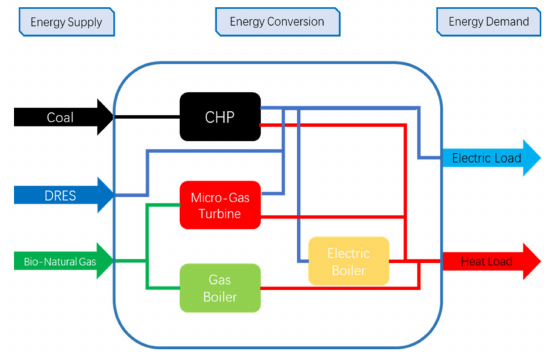
Figure 1. The composition of the integrated energy